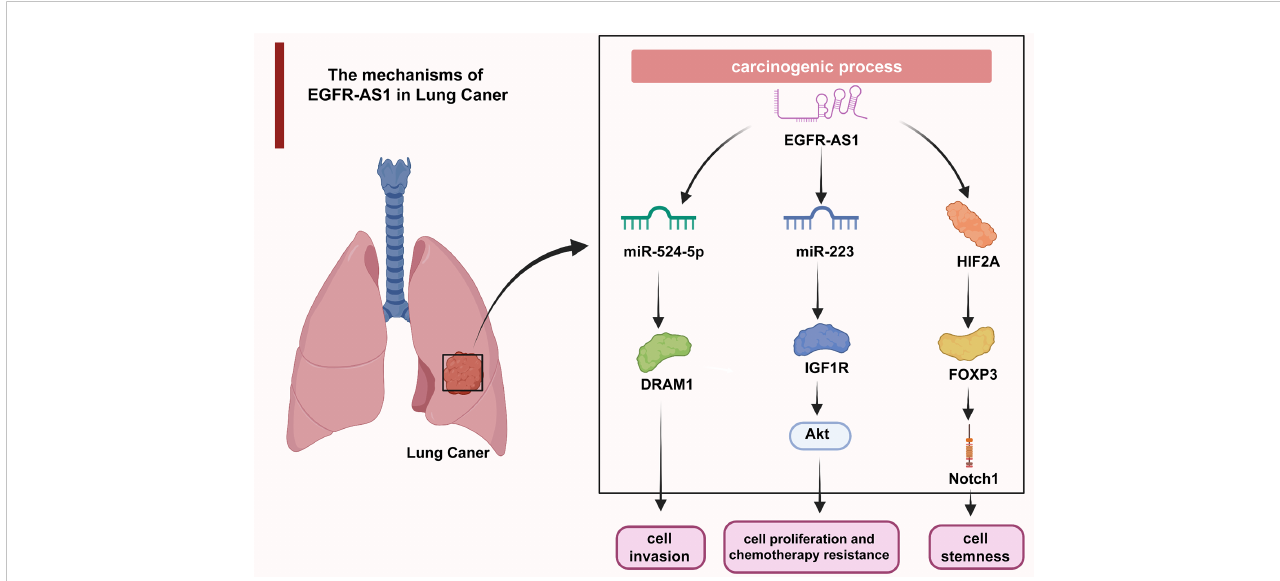
FIGURE 2 In lung cancer, EGFR-AS1 enhanced cell proliferation, chemotherapy resistance, invasion, and stemness via the miR-524-5p/DRAM1 axis, miR-223/IGF1R/ AKT signaling pathway, and HIF2A/FOXP3/Notch1